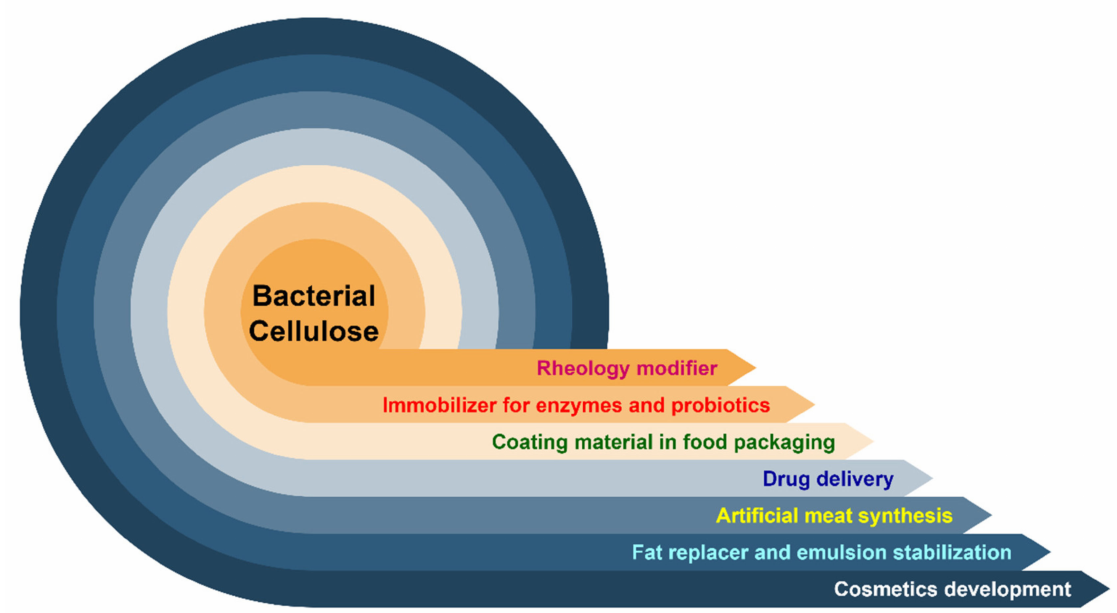
Figure 4. Applications of bacterial cellulose in different